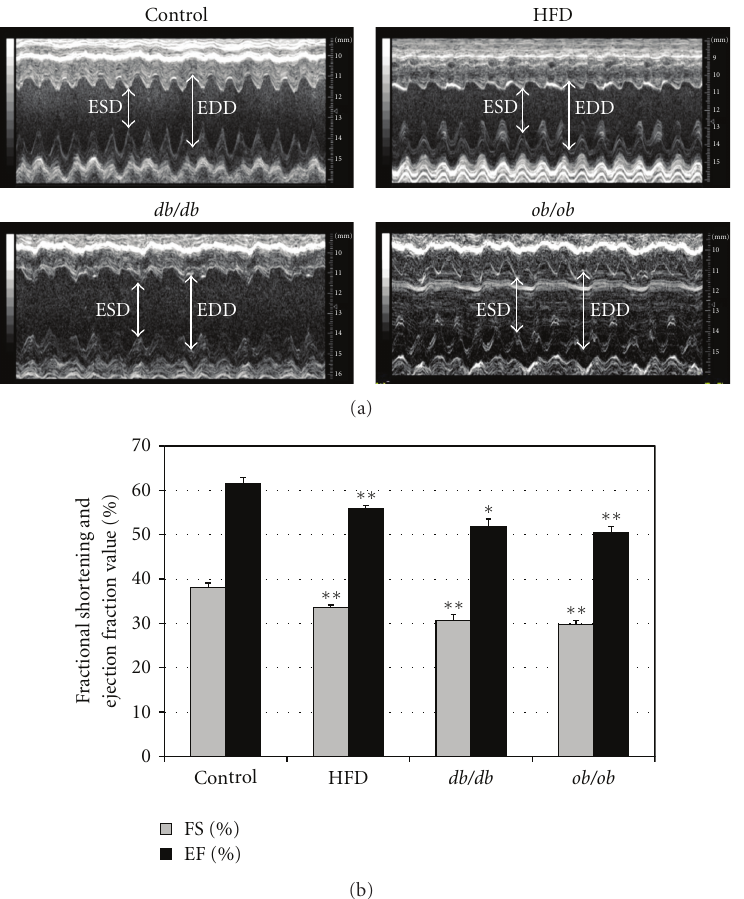
Figure 3: Cardiac function was assessed by echocardiography. (a) M-mode image of the left ventricle in the parasternal short-axis view, showing depth markers. EDD: left ventricular end-diastolic diameter. ESD: left ventricular end-systolic diameter. (b) Fractional shortening of the diameter of the left ventricle between the contracted and relaxed states and ejection fraction were calculated from echocardiographic measurements made during the cardiac cycle. Ejection fraction (EF) is the fraction of the end-diastolic volume that is ejected with each beat; that is, it is stroke volume (SV), divided by end-diastolic volume (EDV). ∗ P < 0 . 05, ∗∗ P < 0 . 01 compared with the control